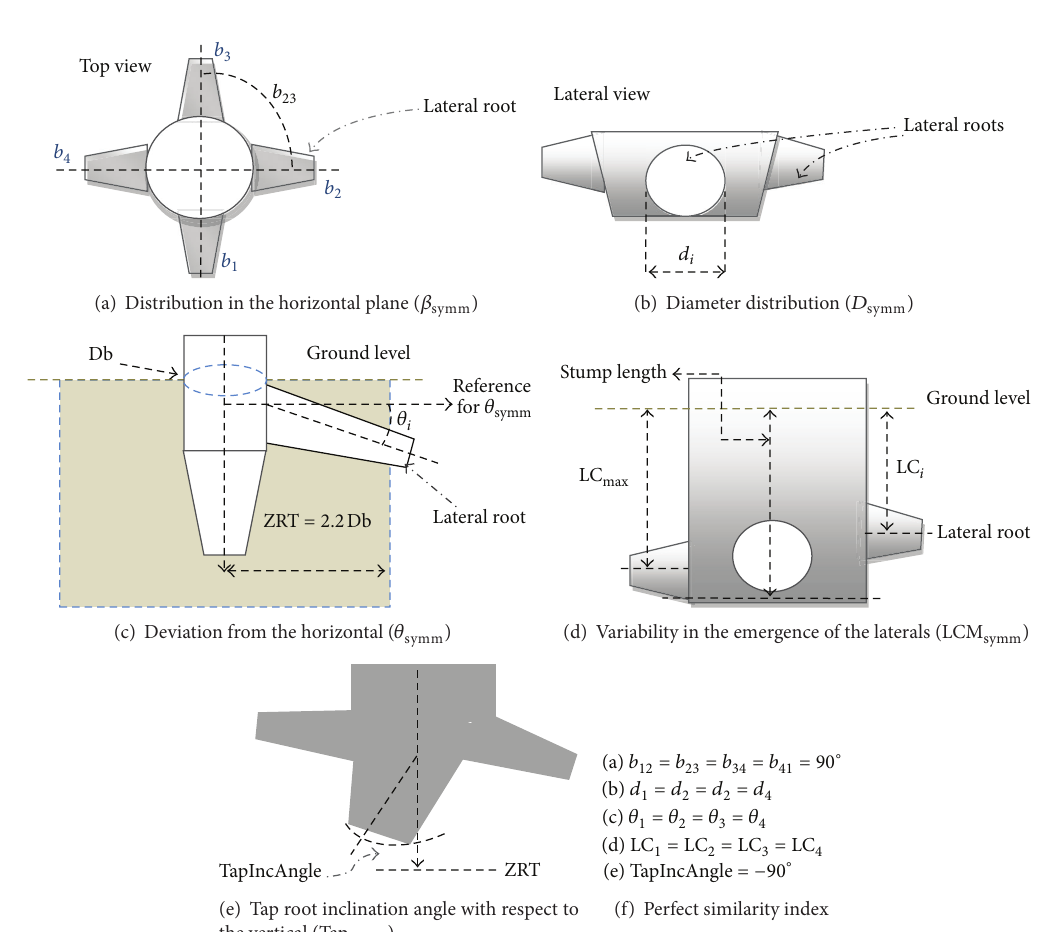
Figure 4: Parameters considered for calculating the similarity index and its component measurements.